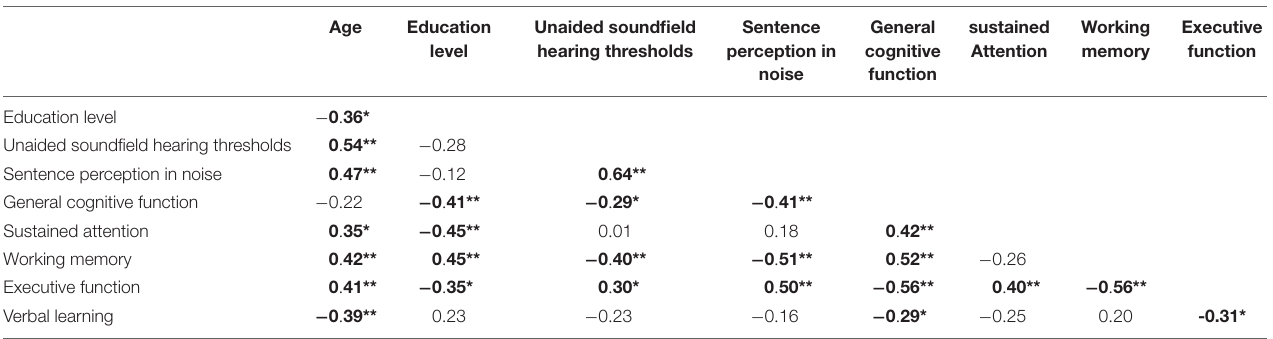
TABLE 2 | Correlations among variables in the UT group.